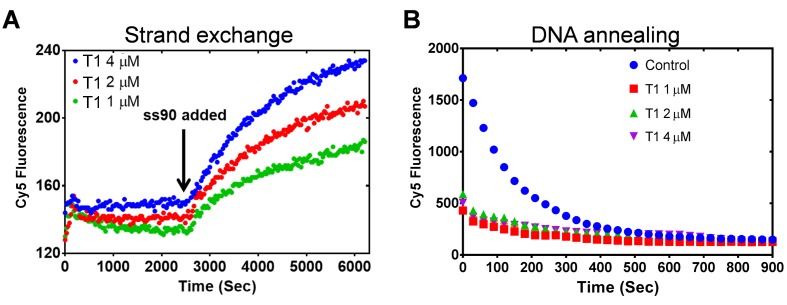
PALB2 does not unwind dsDNA and anneals complementary DNA strands.(A) Strand exchange reaction where Cy5/Iowa ds35 DNA (100 nM) was first incubated with three different concentrations of N-DBD for 30’. The complementary ss90 DNA (100 nM) was added at 30' to initiate the strand exchange. (B) Annealing of Cy5- and Iowa-labelled complementary ss35 strands (100 nM) in the presence of different concentrations of PALB2 N-DBD. Buffers are identical to those in Figure 4.